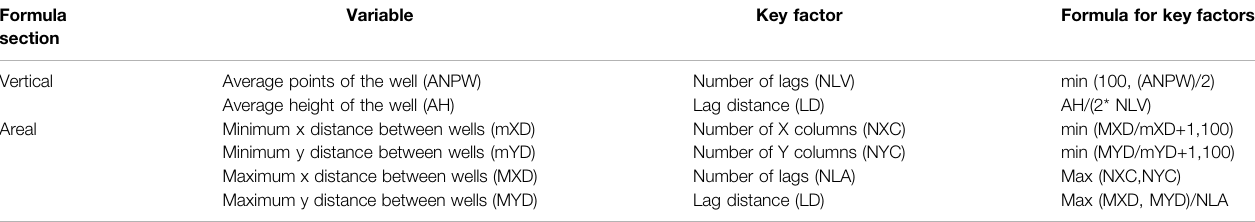
TABLE 1 | Empirical formulas in parameter settings.